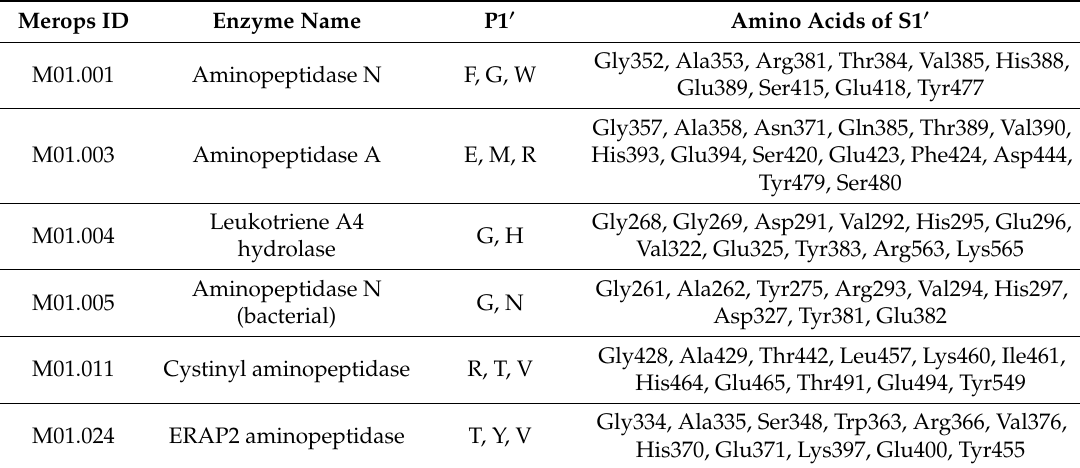
Table 2. Selected M1 aminopeptidases with the P1 (cid:48) -preferred amino acid in the S1 (cid:48) binding pocket with residues forming the cavity.